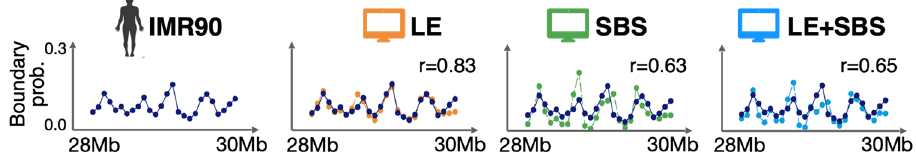
Figure 2. The genomic boundary probability function of the IMR90 locus is consistently recapitulated by the different models. Adapted from [28].